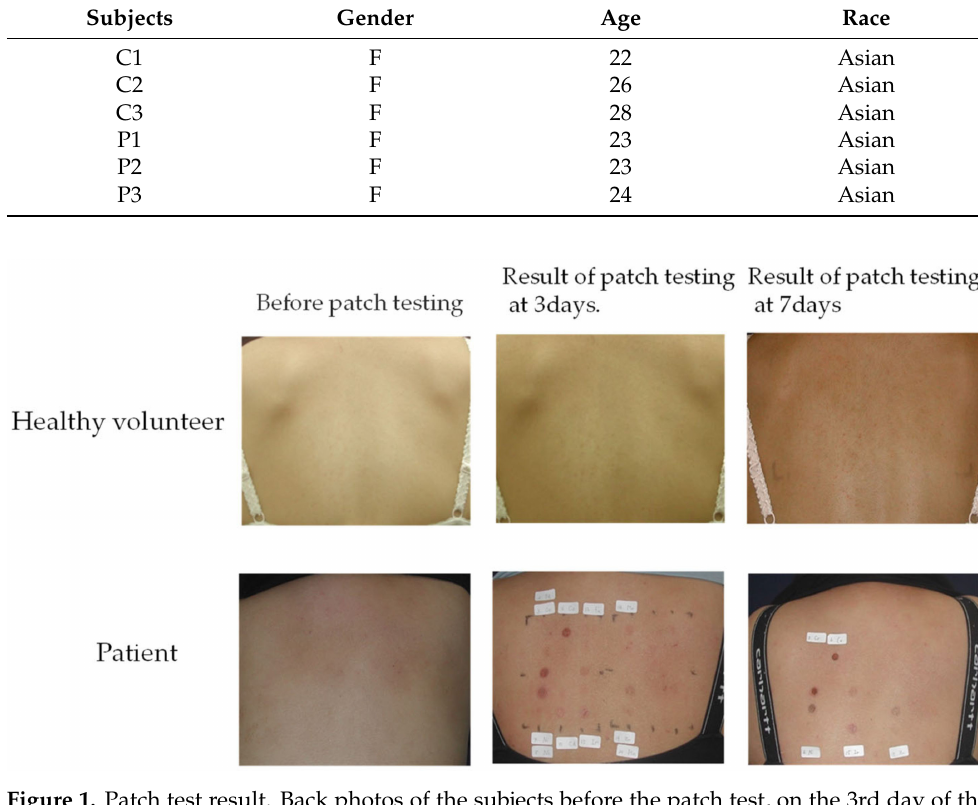
Figure 1. Patch test result. Back photos of the subjects before the patch test, on the 3rd day of the patch test and on the 7th day of the patch